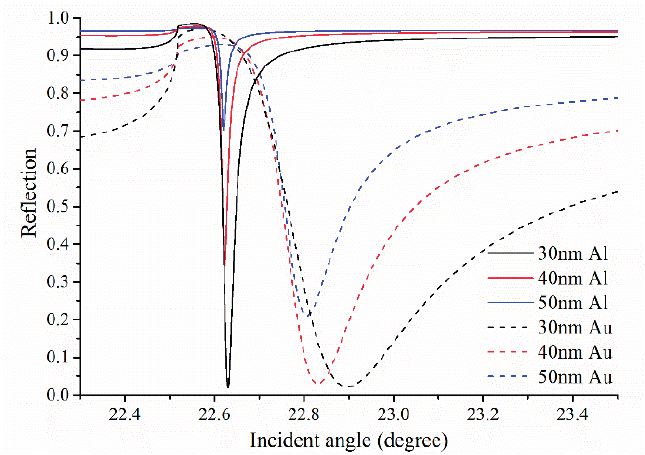
Figure 5. The single metallic SPR curve of angular interrogation for different thickness of the metal (Au or Al) layer at operating wavelength of 1550 nm and the refractive index of the analyte solution n a =